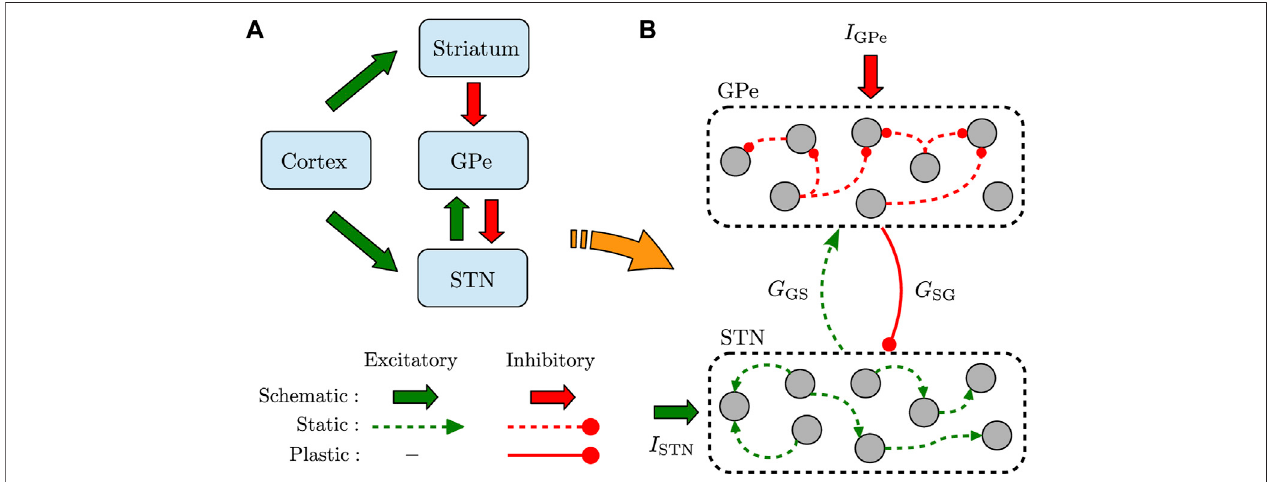
FIGURE 1 | Schematic illustration of the recurrently connected GPe-STN network. (A) GPe receives inhibitory input from striatum via the indirect pathway and relaysittowardSTN.Furthermore,STNreceivesexcitatoryinputfromcortexviathehyperdirectpathway. (B) StructureoftheGPe-STNnetworkwhereonlythesynaptic connections in the pallido-subthalamic pathway (solid red) are modi fi ed according to iSTDP. G SG ( G GS ) denotes the mean GPe → STN (STN → GPe) synaptic strength, and I GPe ( I STN ) represents the external current applied to GPe